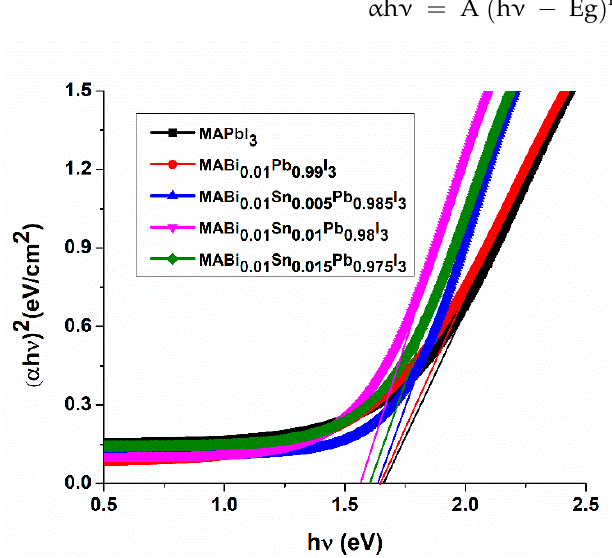
Figure 3. E g of pure and Bi–Sn co-doped MAPbI 3 films.